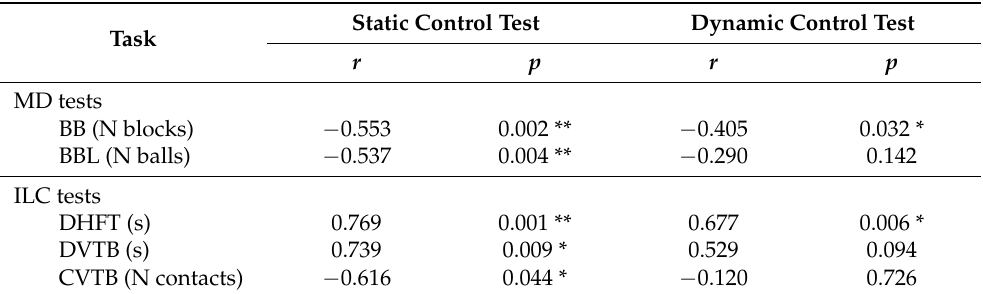
Table 2. Pearson product correlation between intra-limb coordination and static and dynamic trunk control